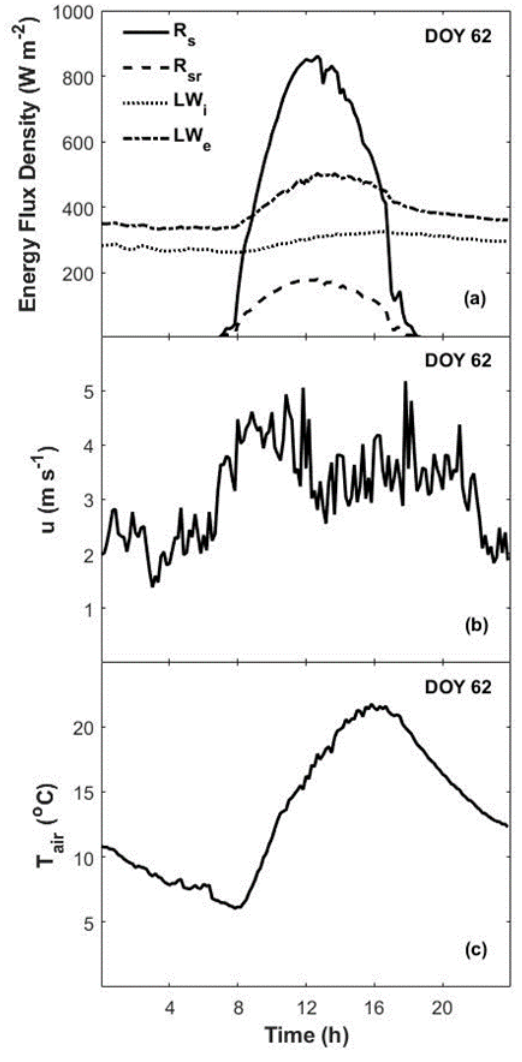
Figure 9. Environmental conditions on day of year (DOY) 62. ( a ) Solar irradiance (Rs), reflected solar irradiance (Rsr), incoming longwave sky radiation (LWi), emitted longwave radiation by the surface underneath the discs (LWe), ( b ) wind speed (u), and ( c ) air temperature (Tair) were measured at the height of the discs.